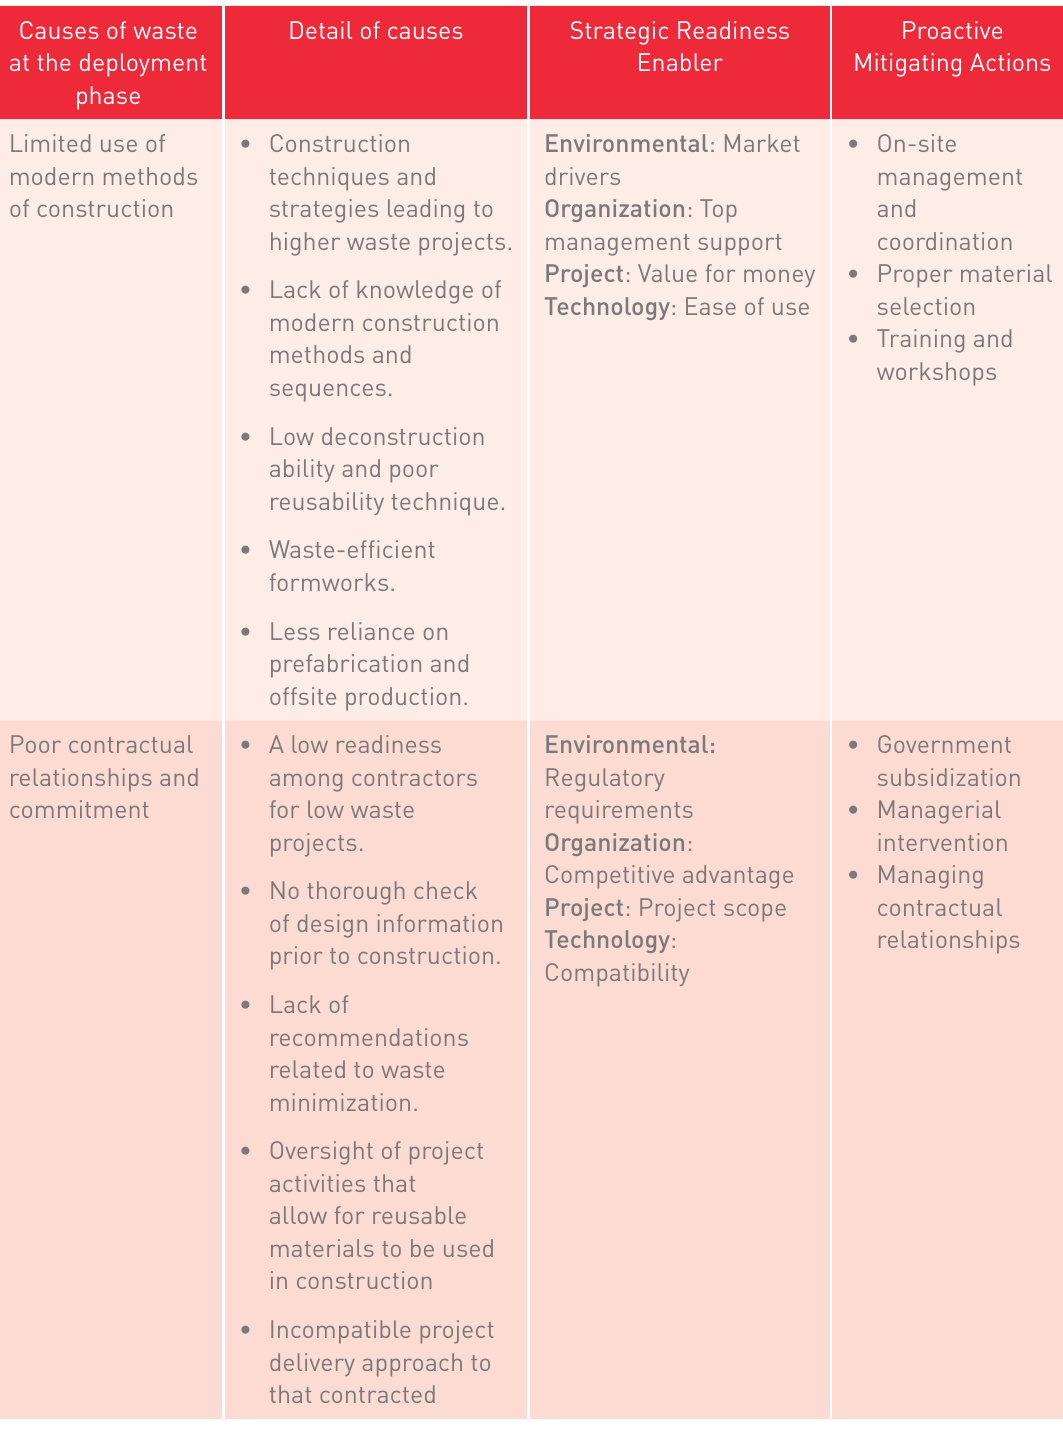
Table 6. The main causes and sources of waste during the deployment phase Causes of waste at the deployment